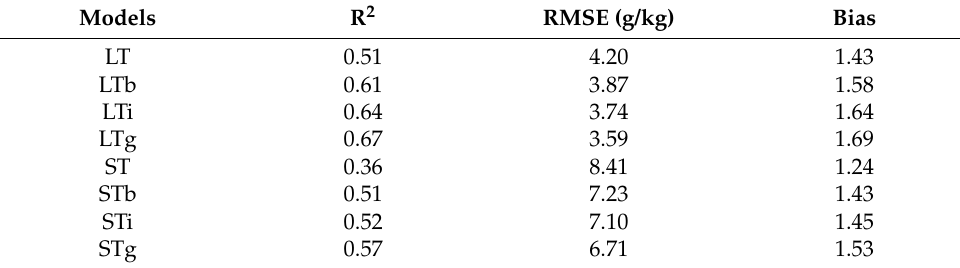
Table 4. Validation results of different SOC